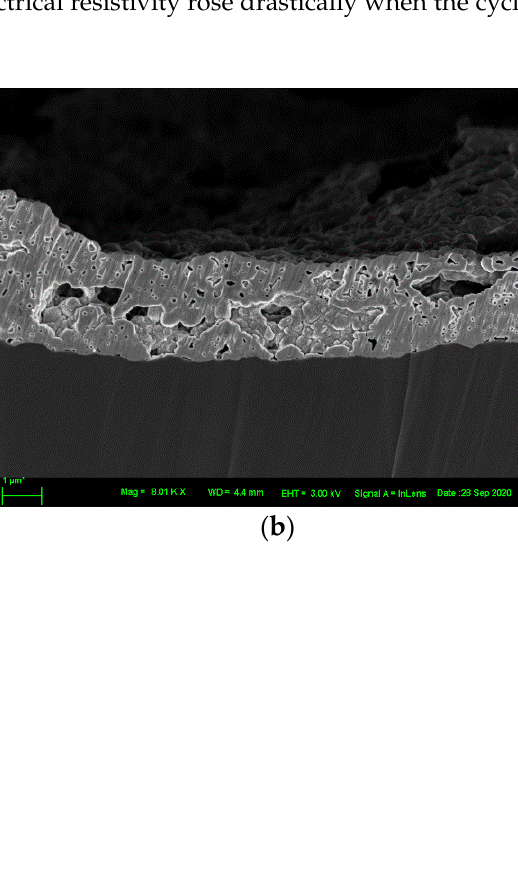
Figure 6. The relationship between the number of bends for test pieces and their respective electrical resistivity: ( a ) substrates modified using different plasmas, and ( b ) substrates modified by O 2 plasma, and air plasma with different processing periods.